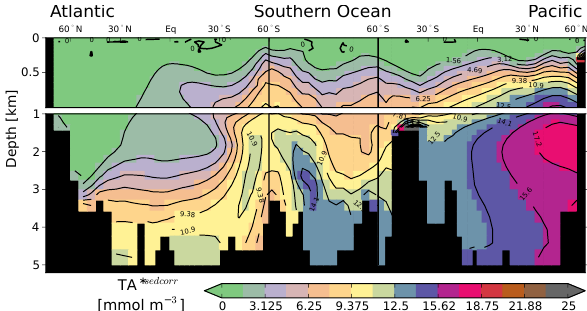
Figure 3. Influence of ocean–sediment fluxes on TA ∗ . The mean offset in TA ∗ between simulations with and without the sediment module is shown for the 14 ensemble members with the highest skill. Displayed are results for a cross section through the Atlantic (25 ◦ W), across the Southern Ocean (58 ◦ S) into the Pacific, and through the Pacific (175 ◦ W). Note the colour bar.